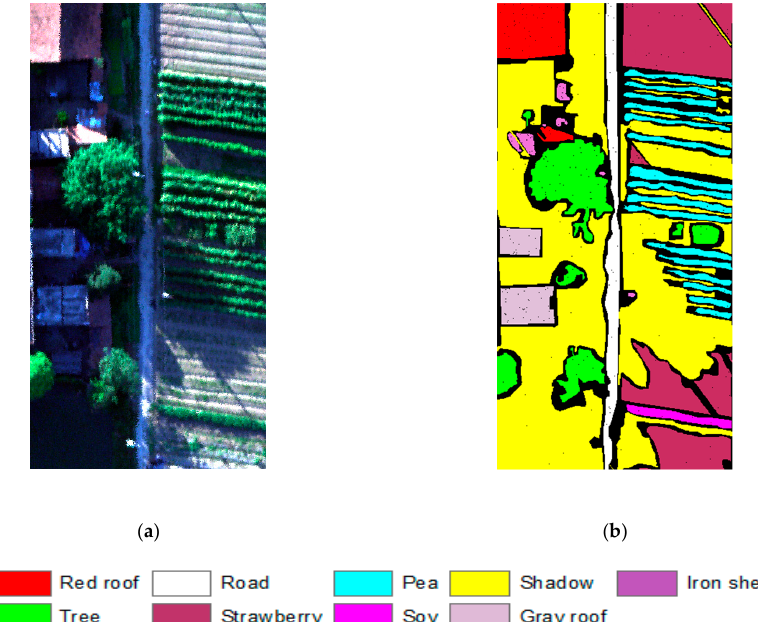
Figure 6. The Hanchuan dataset: ( a ) The true-color image; ( b ) the ground-truth map.